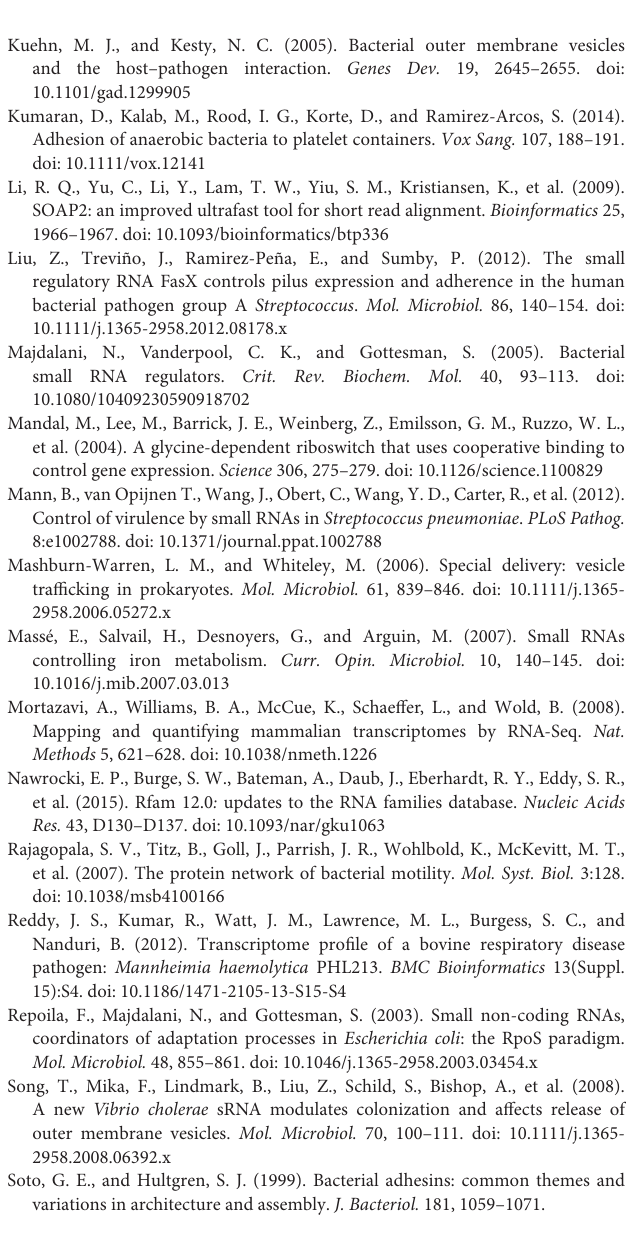
FIGURE S1 | Length distribution of candidate ncRNAs. (A) Length distribution of all ncRNAs as a whole. (B) Length distribution of the ncRNAs of each sample. FIGURE S2 | Gene ontology analysis of target genes of differentially expressed ncRNAs in the Cu-stressed group. FIGURE S3 | Gene ontology analysis of target genes of differentially expressed ncRNAs in the Pb-stressed group. FIGURE S4 | Gene ontology analysis of target genes of differentially expressed ncRNAs in the Hg-stressed group. FIGURE S5 | Gene ontology analysis of target genes of differentially expressed ncRNAs in the low-pH-stressed group. TABLE S1 | Primer sequences used in QPCR analysis.